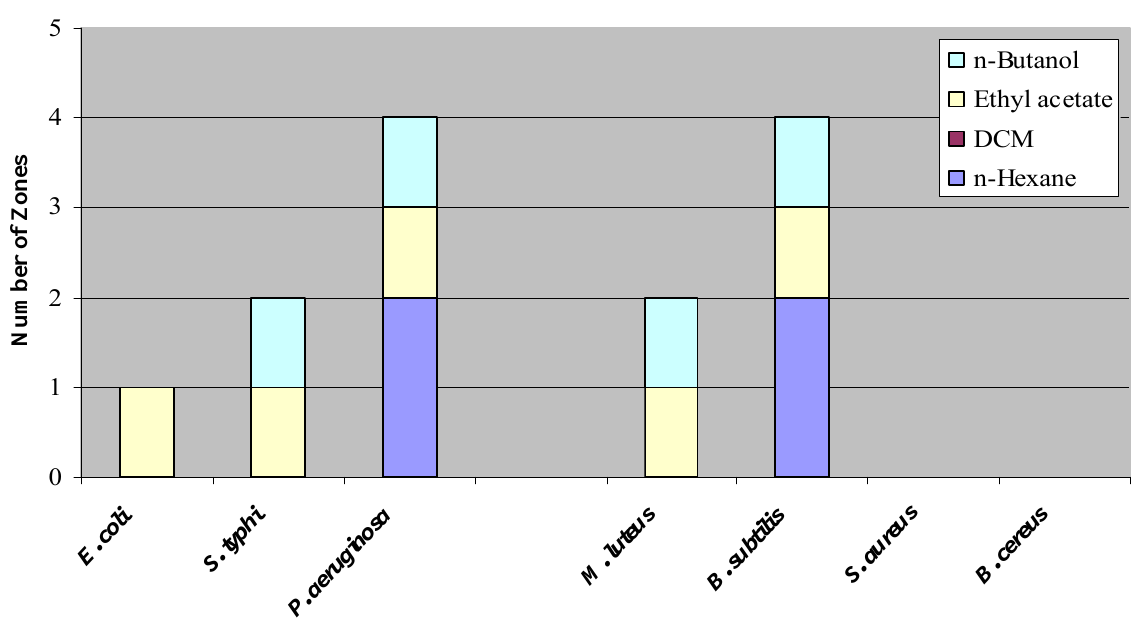
Figure 1 . Number of Inhibition Zones Against Test